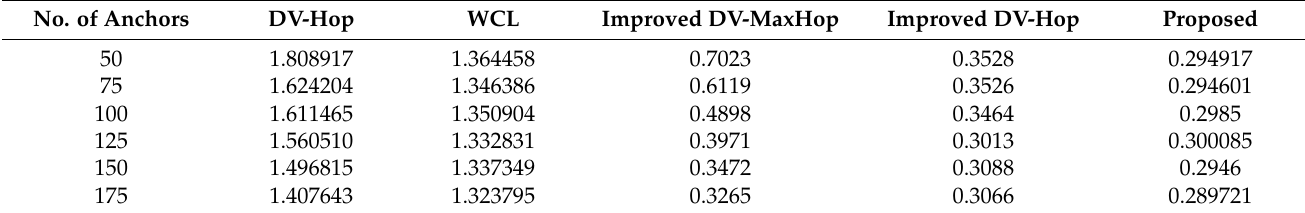
Table 8. Comparison of localization error under various anchor node